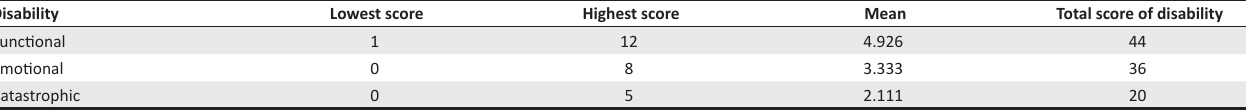
TABLE 4: Lowest and highest scores obtained for emotional, functional and catastrophic disability on the Tinnitus Handicap Inventory ( N = 27). Disability